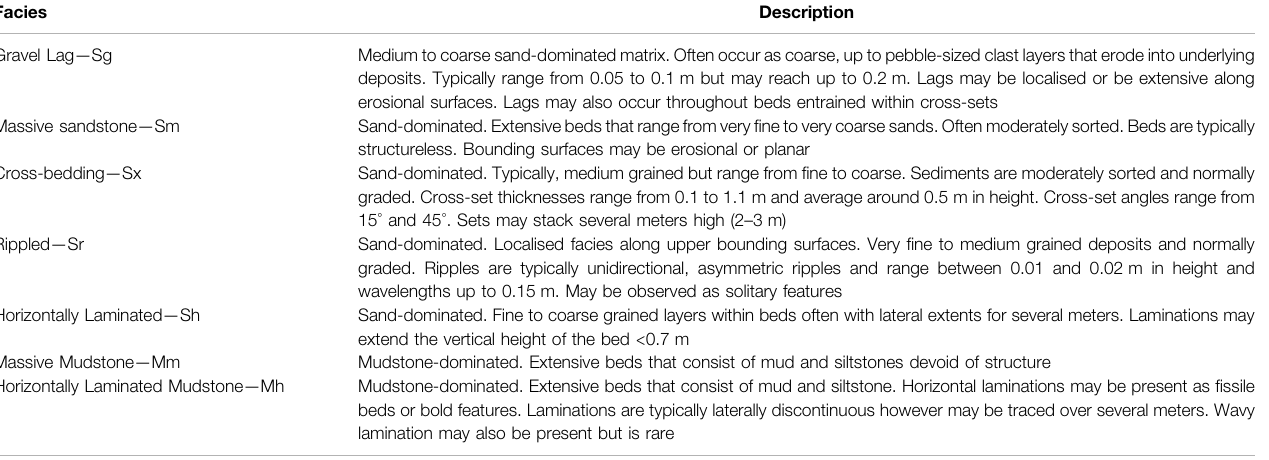
TABLE 1 | Summary of facies.